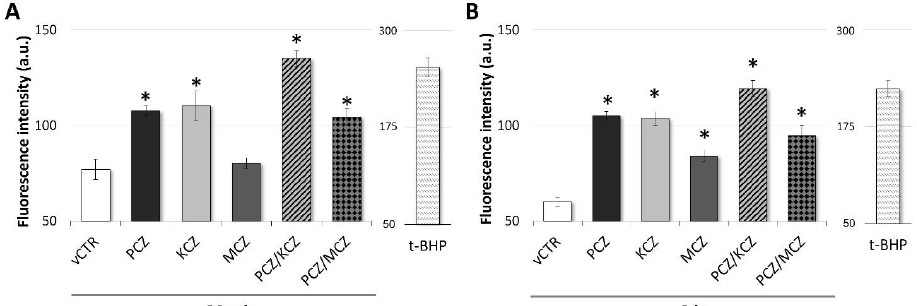
Figure 5. Exposure to azole drugs triggers early ROS production in TM4 cells. ROS production in TM4 cells incubated in the absence (vCTR) or in the presence of azoles fungicides, alone and in combination, for 30 min ( A ) and 3 h ( B ); intracellular ROS generation was detected by measuring DCFH-DA fluorescence with a fluorimeter, and determined in terms of fluorescence intensity (arbi- trary units, a.u.); cells treated with 500 µM tert-butyl hydroperoxide (t-BHP) for 1.5 h were used as a positive control for ROS generation (A-B). Values from three independent experiments are ex- pressed as medians ± SE; one-w ay ANOVA followed by Dunnett’s test; * p < 0.05 vs. vCTR.